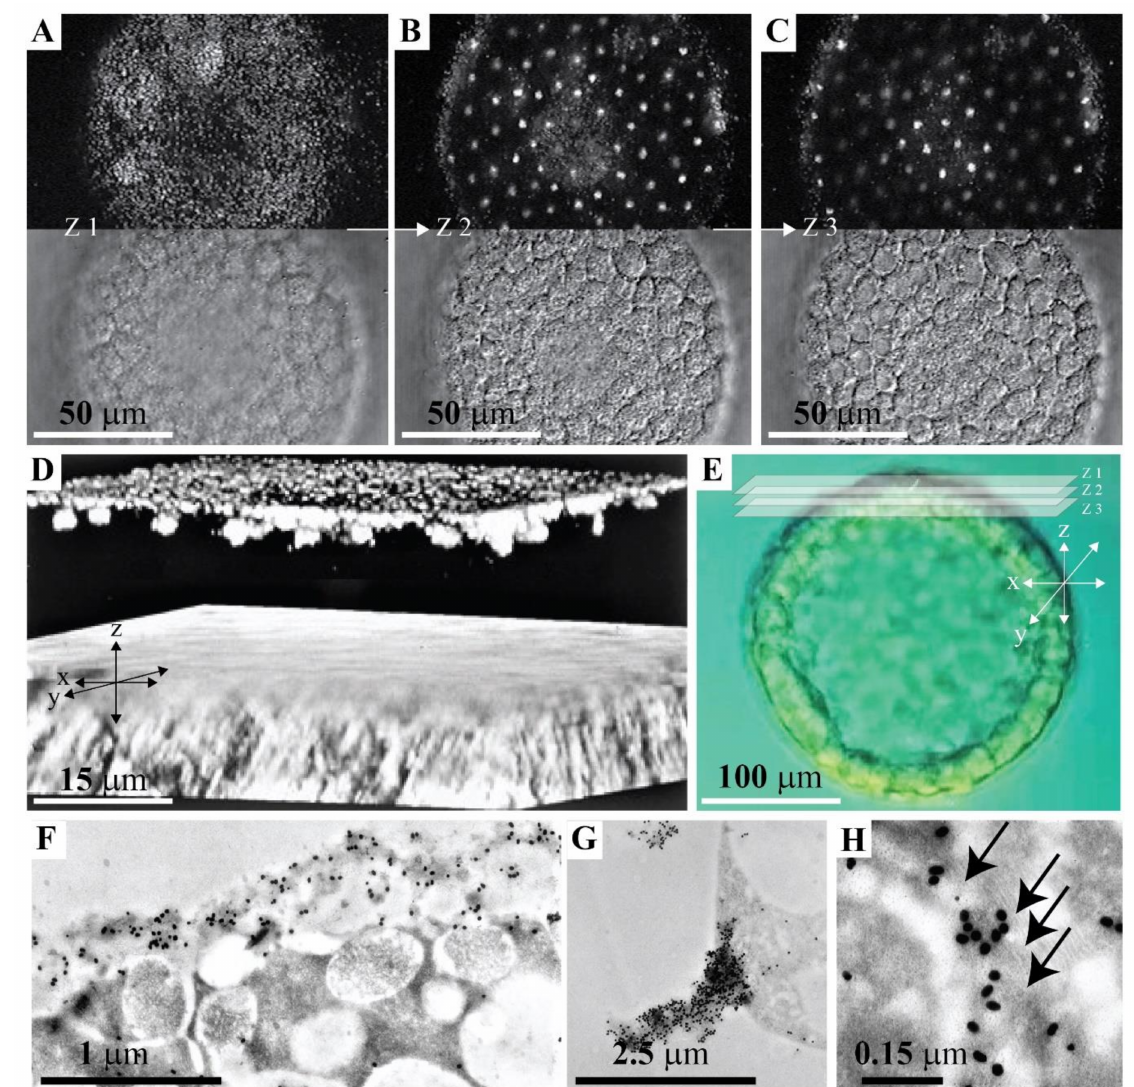
Figure 3. Immuno-histological localization of the GN1 glycan adhesion epitope in L. pictus hatched blastula. ( A – C ) im- munofluorescence confocal microscopy of L. pictus hatched blastula stained with the ant-GN1 Block 2 monoclonal antibody. Whole mounts of blastula L. pictus embryos were stained with 100 µ g/mL Block 2 as described in Materials and Methods. ( A – C ) parfocal series of compost images from fluorescence (upper image) and transmitted light (lower image) were taken with Zeiss 63 × objective every 0.6 µ m in z -axis starting from the apical part of ectodermal cells. Image in z -axis at distance from scan beginning ( A ) 0.0 µ m ( B ) 1.2 µ m, ( C ) 2.4 µ m, ( D ) three-dimensional reconstruction of the embryo part obtained from images scanned with 63 × objective, ( E ) image of the whole embryo, ( F – H ) immunogold electron microscopical localization of the glycan adhesion epitope in L. pictus hatched blastula, ( F ) apical lamina with microvilli, ( G ) part of microvilli, and ( H ) Golgi complex. Arrows mark